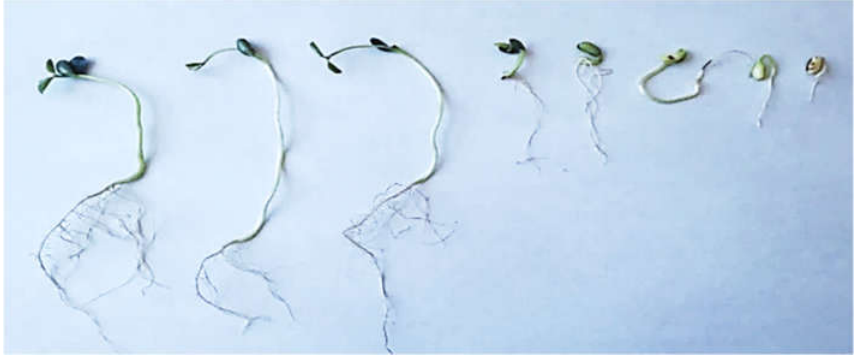
Figure 2. Soybean seedlings: normal (3 on the left) and